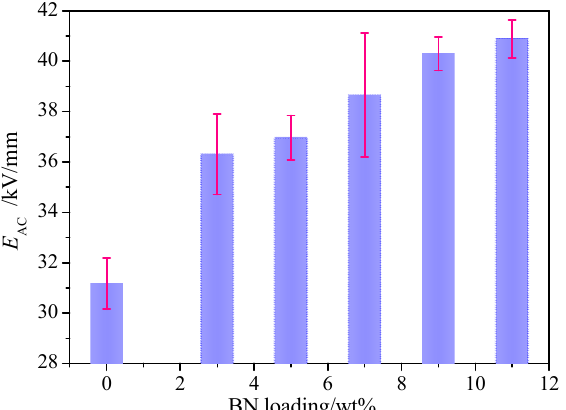
Figure 8. Influence of BN filler-content on E AC of PTFE/BN composites.